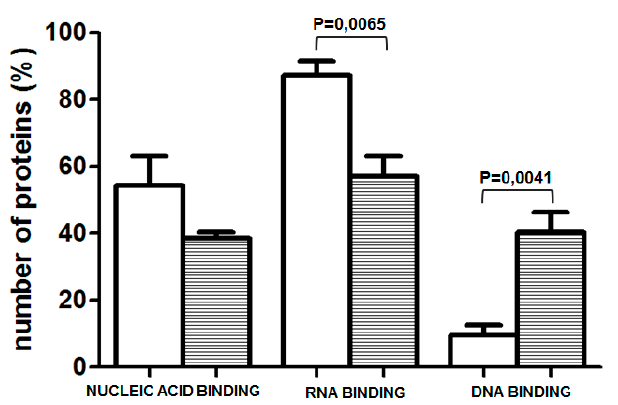
Figure 4. Percentage of proteins classified as nucleic acid binding and, within this category, as RNA- or DNA-binding proteins, bound to unmethylated (white bars) and methylated (striped bars). Data obtained in 4 experiments are presented as mean ± SEM.